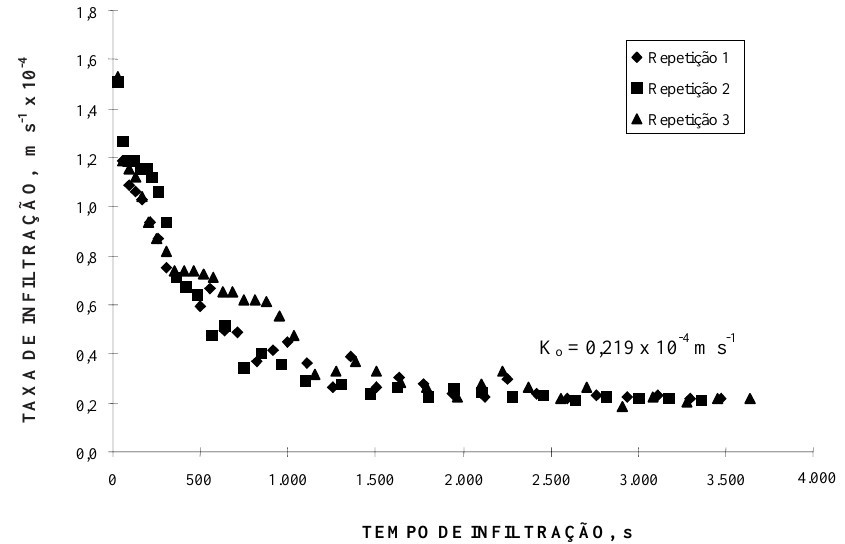
Figura 1. Teste de infiltração para as três repetições do experimento preliminar.